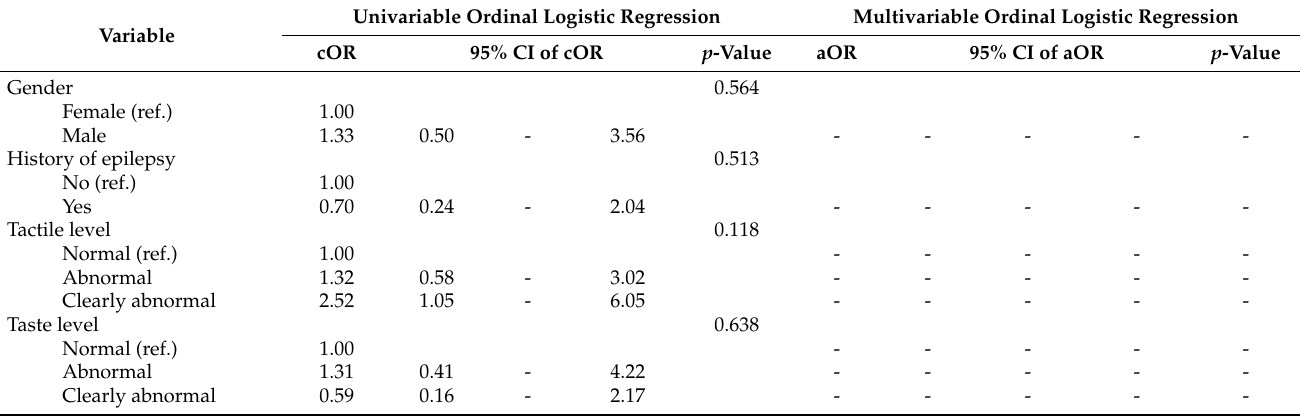
Table 3. The predictive model for factors associated with an abnormal electroencephalograph.